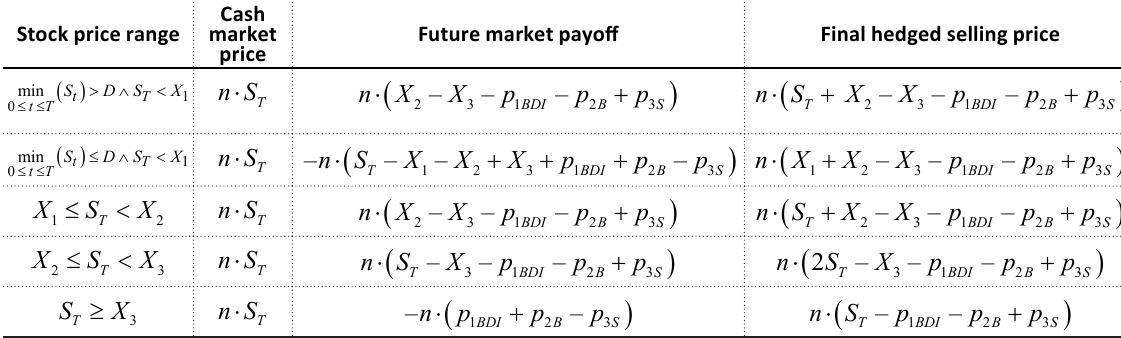
Table 2. Final hedged selling prices using Short Put Ladder option strategy_1 Stock price range